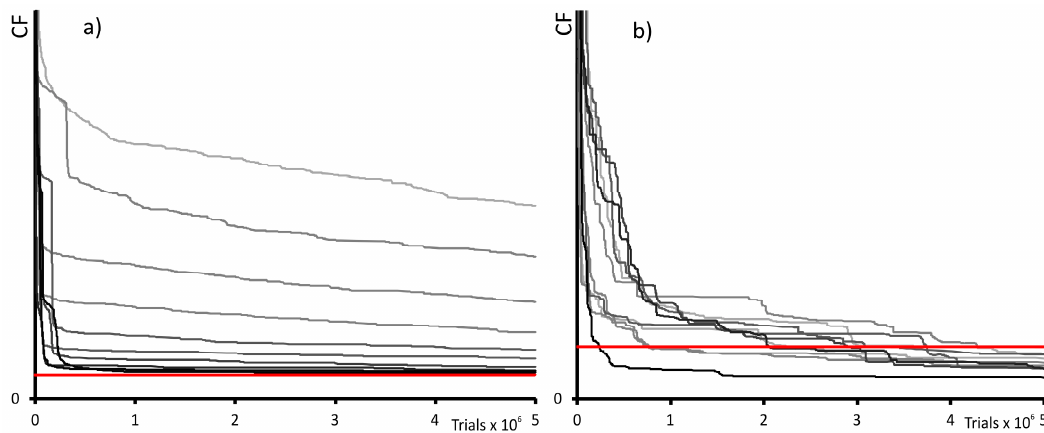
Figure 5. Evolution of the CF (Cost Function) during the 10 runs a ) when the default setting of the optimization algorithm was used and b ) when the MD approach was used. Evolution of CF of each run is drawn with different shade of grey, starting from light grey for the first run, and ending with black for the final, 10th, run. Both graphs are zoomed to see more detail, and the red line shows the value of the CF at 4.26 × 10 6 , which corresponds to the highest resulting CF value in the MD result list, and illustrates the “scale” between left and right graphs.